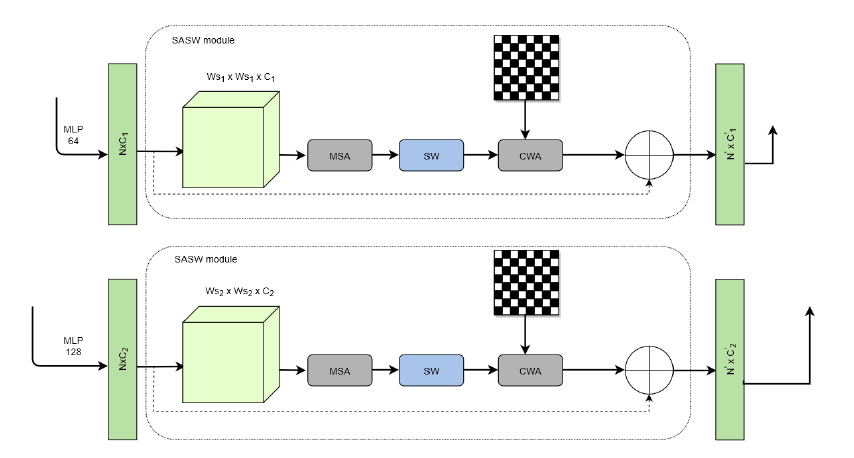
Figure 5. Illustration of the Self-Attention with Shifted-Window part of the PointSwin-E model. The upper and lower parts are two parallel SASW